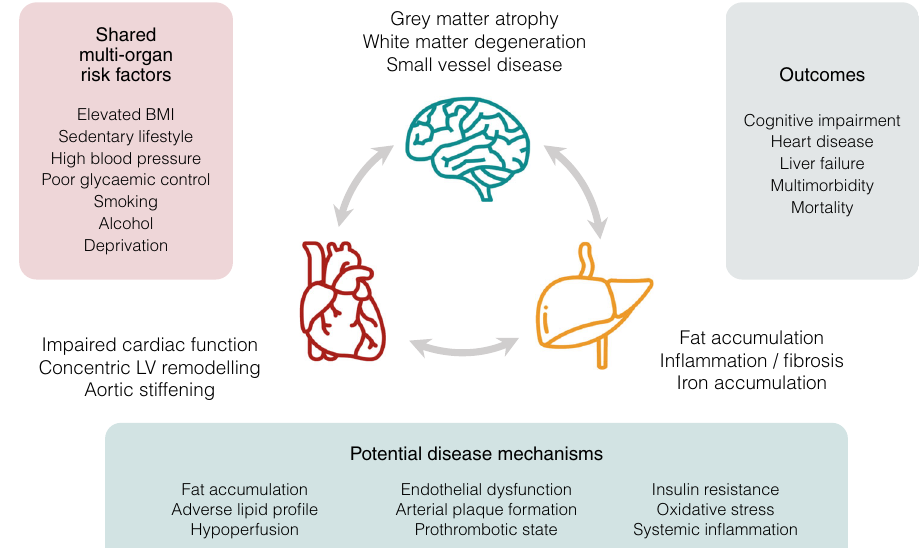
Fig. 1 | Conceptual overview of the heart-brain-liver axis. Heart, brain and liver systems co-exist within a context of shared multi-organ risk factors. In this study, weidentifythewaysthatsubclinicalchangesineachorganassociatewithothersin the heart-brain-liver axis, relevant to a range of possible underlying disease mechanisms.Adetailedunderstandingofmulti-organinteractioncouldpotentially